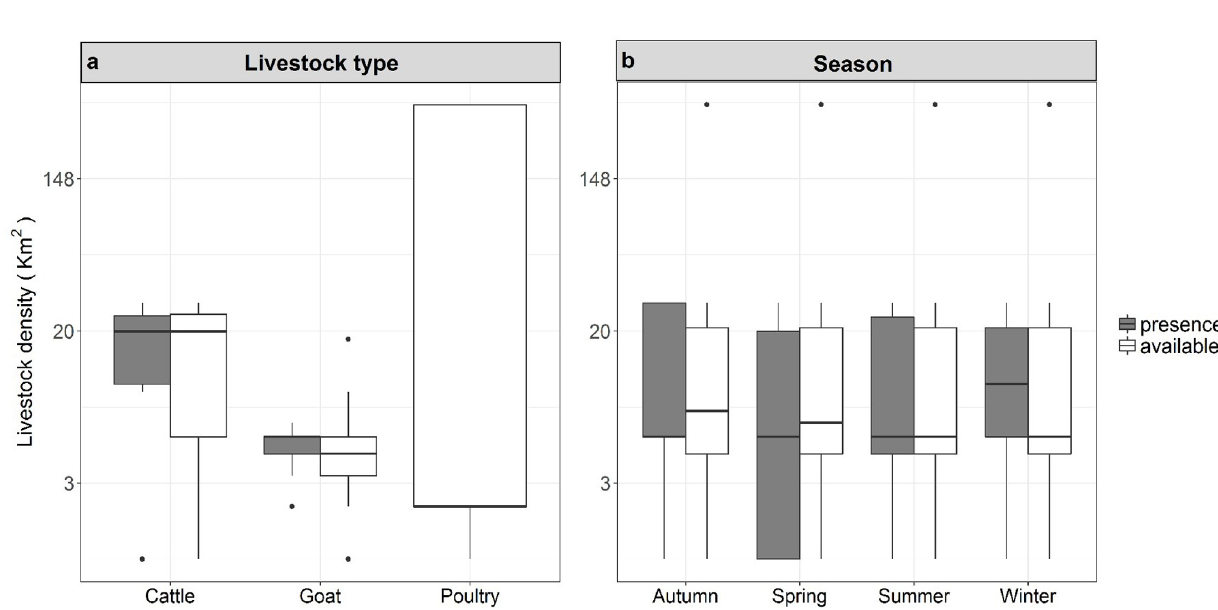
Fig 3. The presence and availability data for the Bluebank wild dog pack in a) areas with different livestock type (cattle, goats and poultry) densities (per km2) and presence and availability data across b) different seasons in the Mpumalanga Province, South Africa. Boxplots show medians (dark horizontal bars), 1st and 3rd interquartiles (boxes), 95% CI (whiskers) and outliers (dots). Presence data are indicated by coloured boxes.